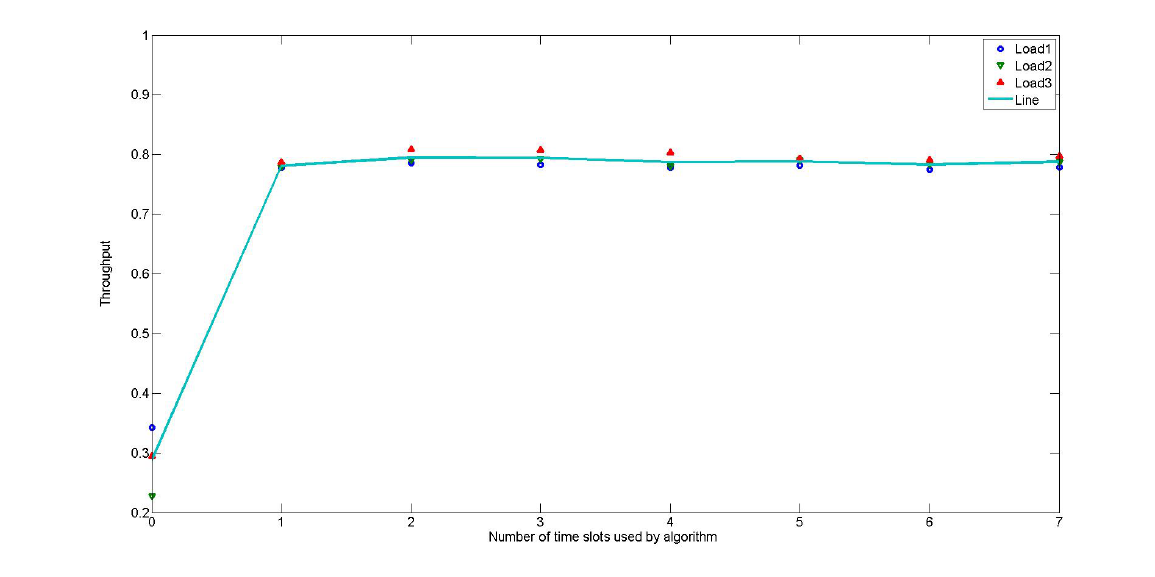
Figure 10. The channel throughput versus the number of time slots N used by Method 3 for three different network load